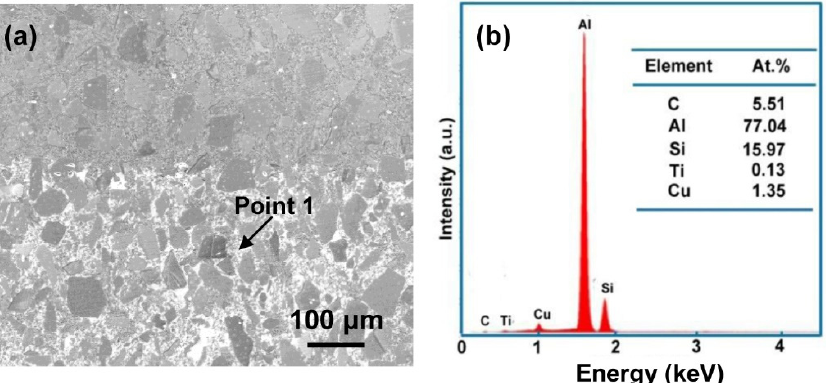
Figure 2. ( a ) SEM image of no infiltration (up) and infiltration (down), ( b ) EDS analysis of Point 1.